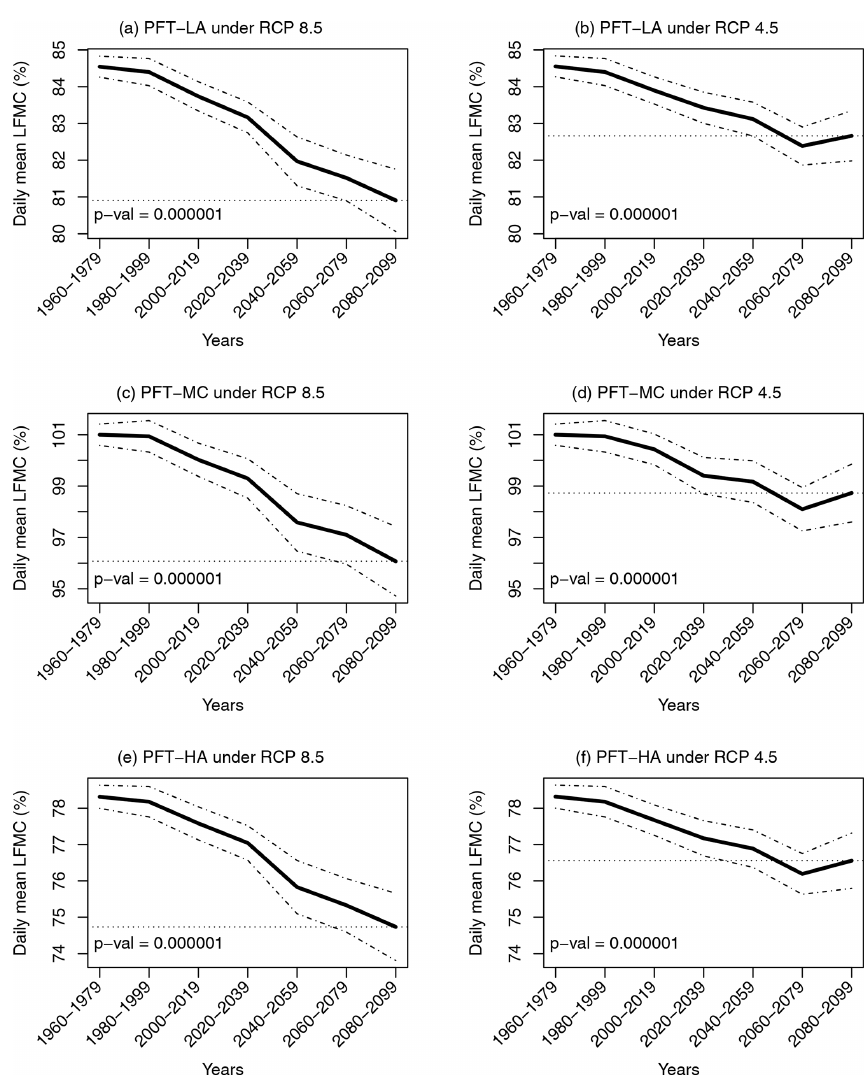
Figure 3. Temporal changes in daily mean live fuel moisture content (black solid line) and 95% confidence interval (black dash-dot line) from 1960 to 2099 for three PFTs (see Fig. 1 for an explanation of the PFTs) under climate scenarios RCP4.5 and 8.5 with 20 Earth system models considering all climatic variables changes. The p values were calculated using bootstrap sampling to test whether the daily mean live fuel moisture content across different models during the future period (2080–2099) was significantly lower than that during the historical period (1960–1999). The gray horizontal dotted line represents the ensemble mean for